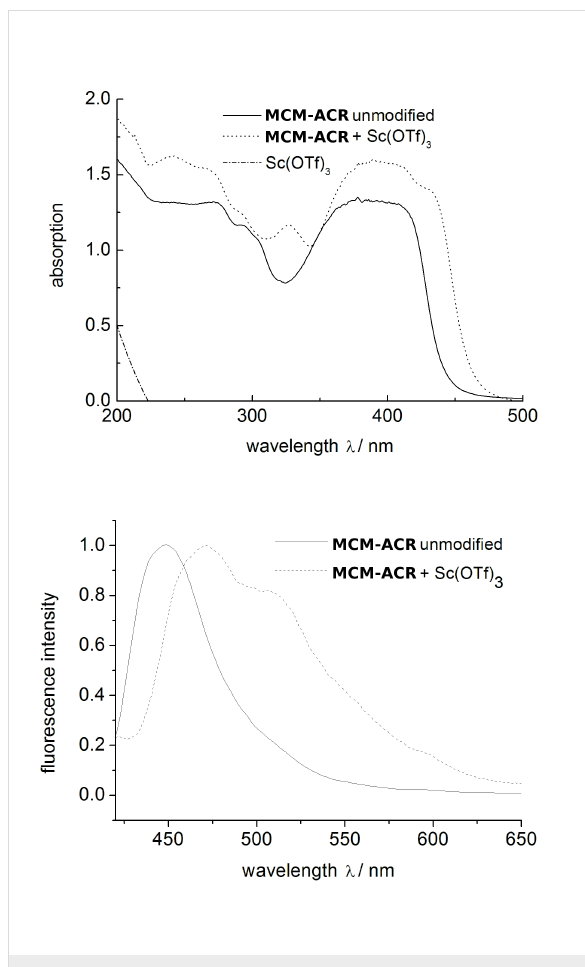
Figure 9: Overlay of the solid state UV-vis (top) and fluorescence (bottom) spectra of MCM-ACR , MCM-ACR + Sc(OTf) 3 and pure Sc(OTf) 3 (fluorescence excitation wavelength λ ex. = 400 nm). UV–vis- absorption intensities are not normalized to a given value;